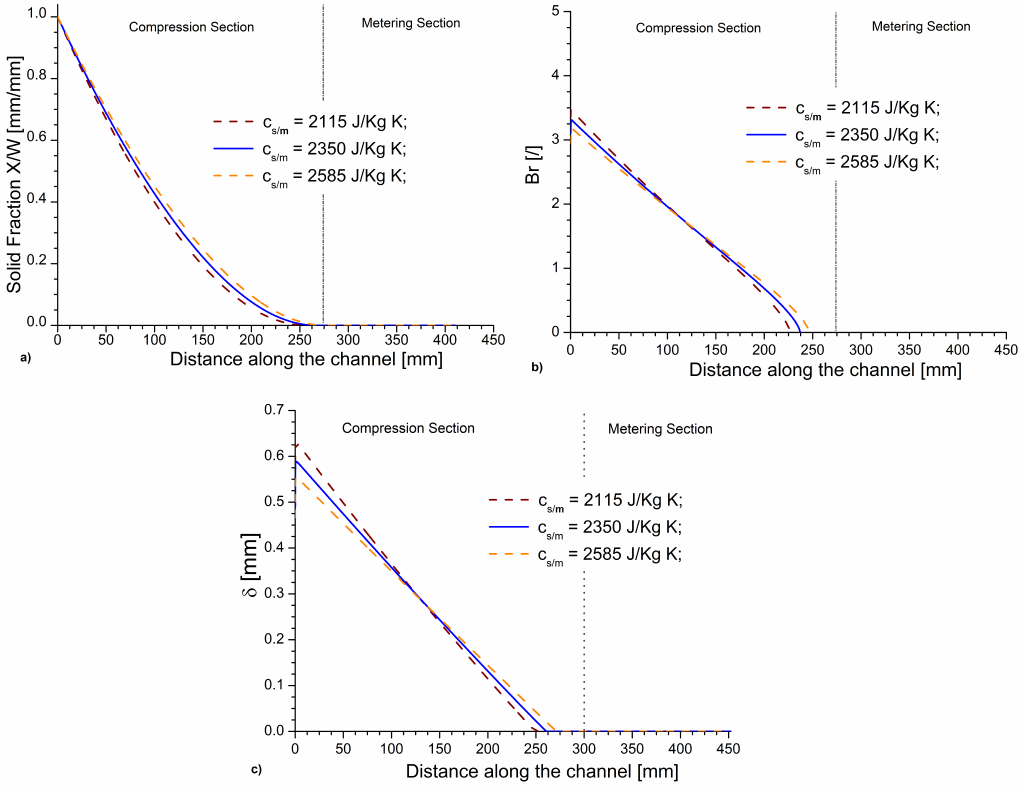
Figure 12. ( a ) Melting profile; ( b ) Brinkman number; and ( c ) melt layer thickness δ for di ff erent specific heat capacities (both solid and melt) considering otherwise the micro-extrusion settings and material parameters of Table 1 (Column 2). Blue (reference) lines as in Figure